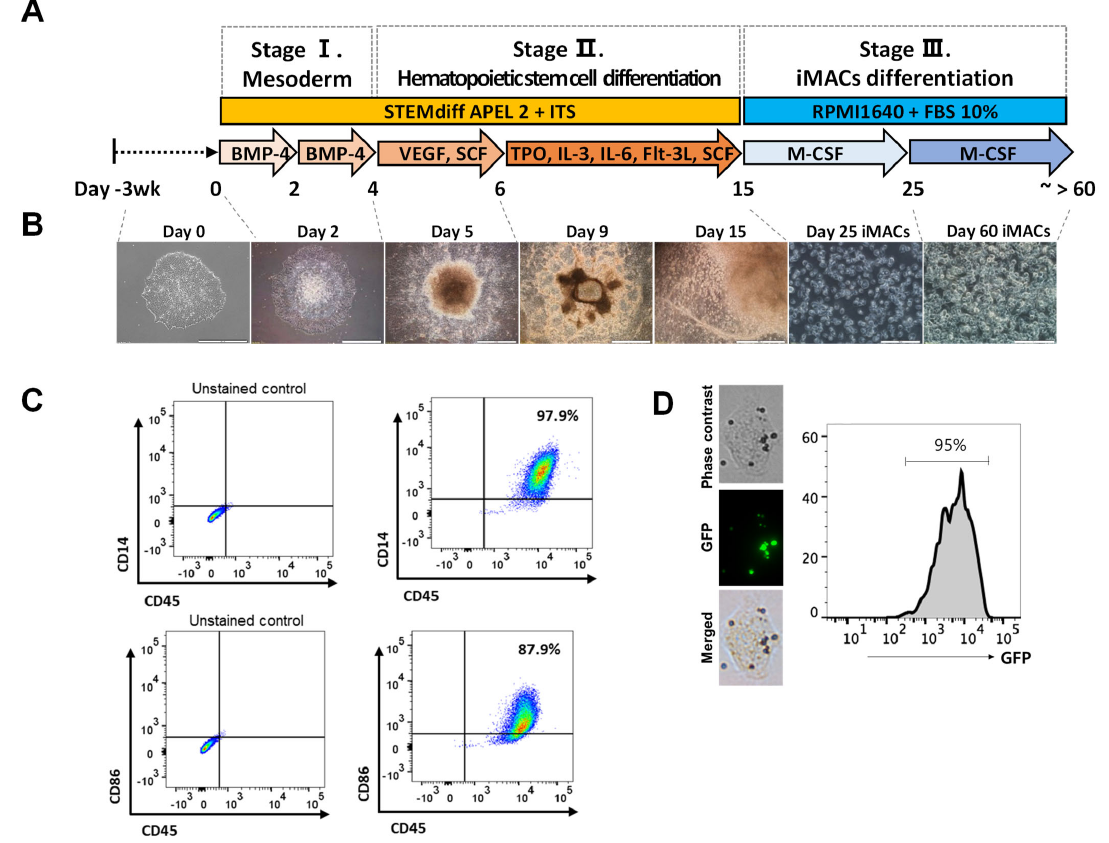
Figure 3. Step-wise macrophage differentiation and characterization of hPSCs-derived Figure 3. Step ‐ wise macrophage differentiation and characterization of hPSCs ‐ derived macro ‐ phages. ( A ) Schematic protocol of the step ‐ wise macrophage differentiation from the hPSCs. ( B )